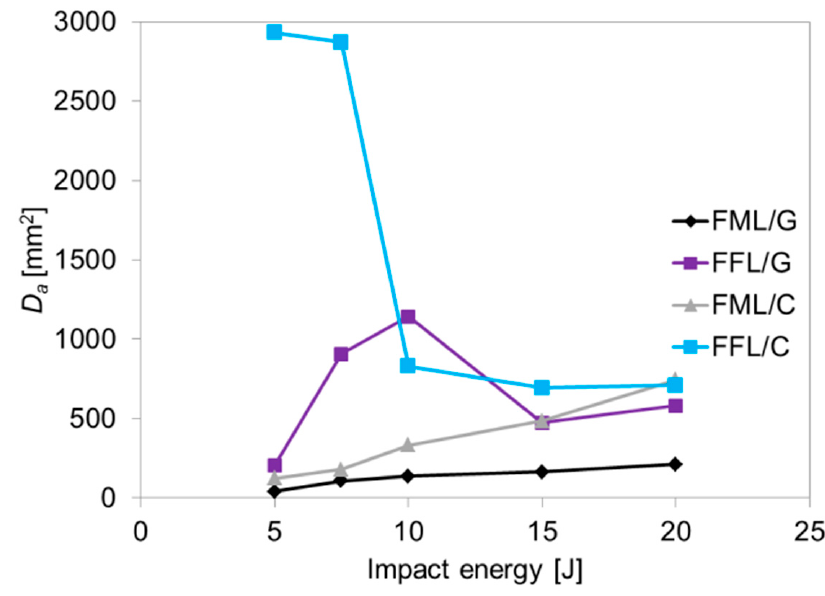
Figure 10. The comparison of damage area of FFL/C, FML/C, FFL/G and FML/G. It was noticed that the damage area of FFL/C laminates decreases with increasing impact energy, while in the case of FFL/G the relation changes from an initial increase (up to the energy of 10 J) to a further decrease (see Figure 10) (extensive testing